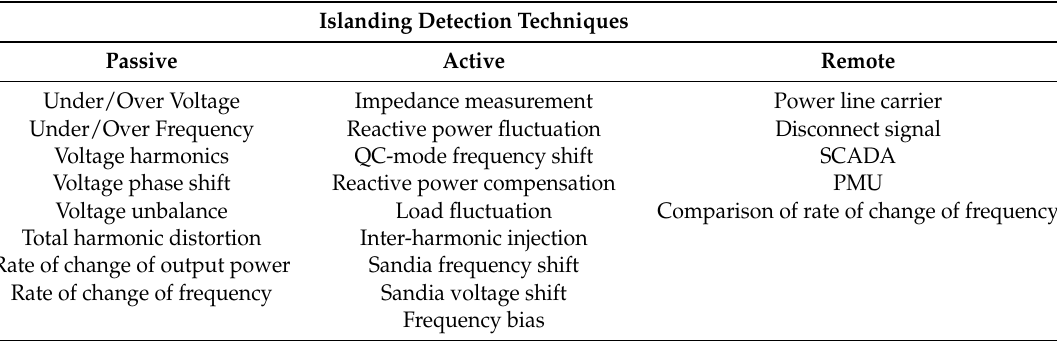
Table 1. Islanding detection methods classification.